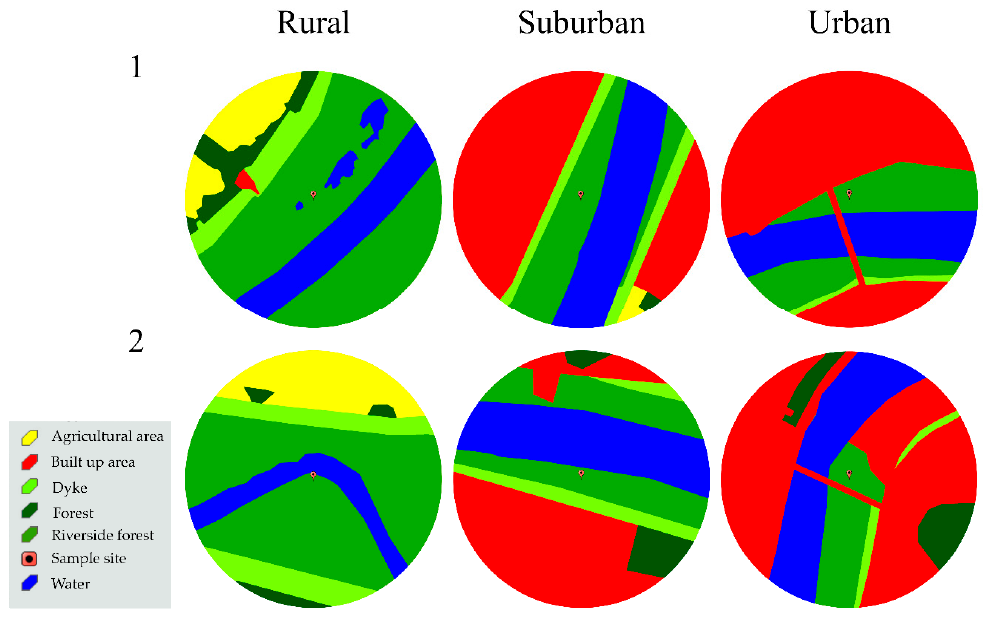
Figure 2. Habitat types within a 500-meter radius of the study plots.